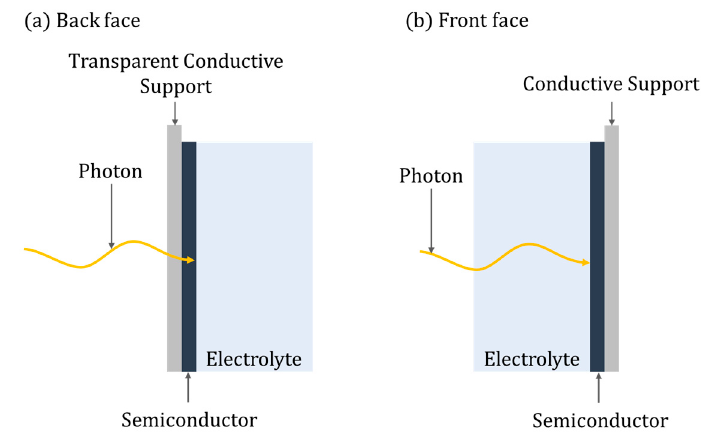
Figure 7. Photoelectrode ordination, ( a ) back face, ( b ) front face.